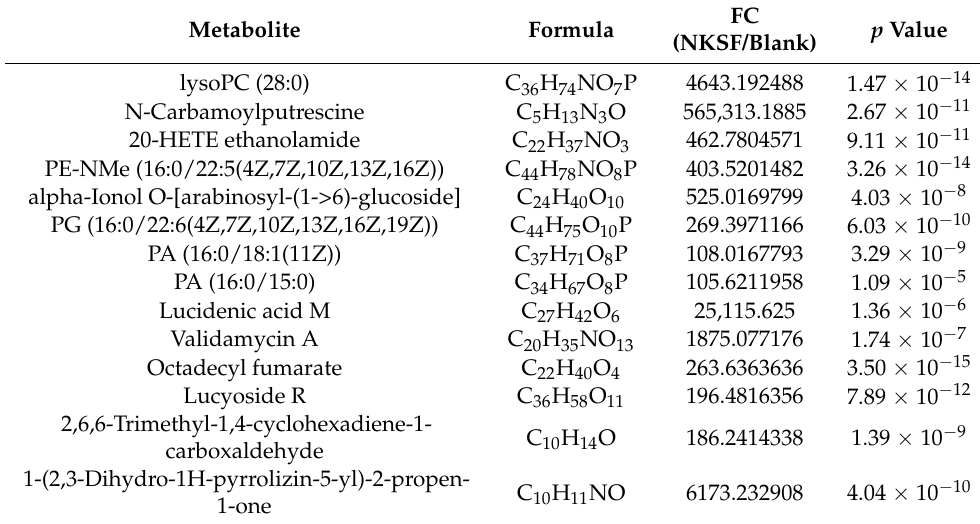
Table 1. Main differential metabolites.